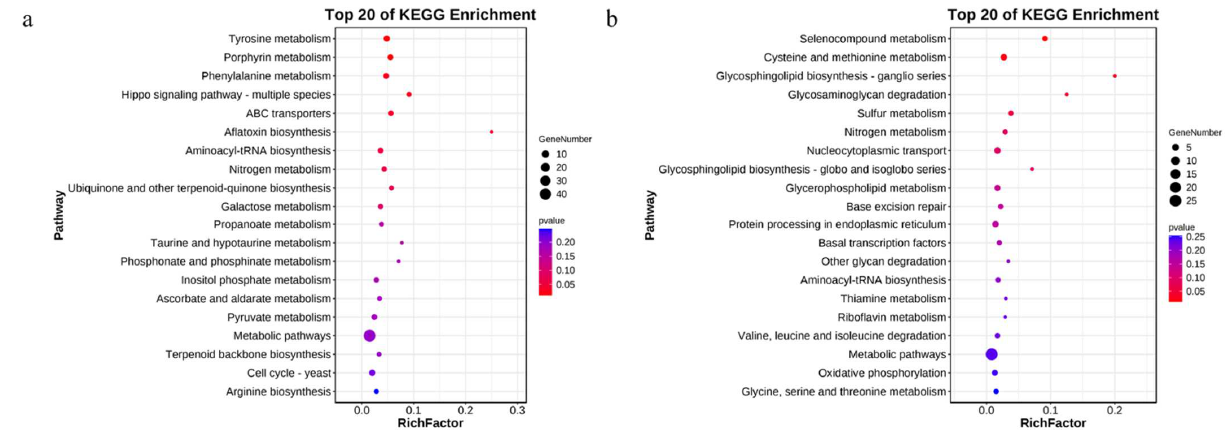
Figure 5. KEGG pathway enrichment analysis of DEGs under different treatments of G. dilepis . (( a ): the upregulated genes; ( b ): the downregulated genes).